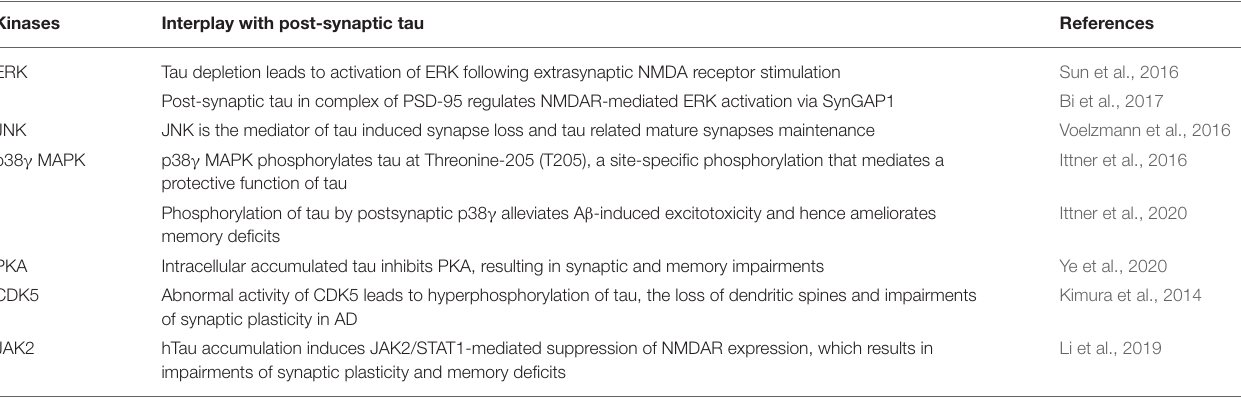
TABLE 1 | Post-synaptic tau and other kinases. Kinases Interplay with post-synaptic